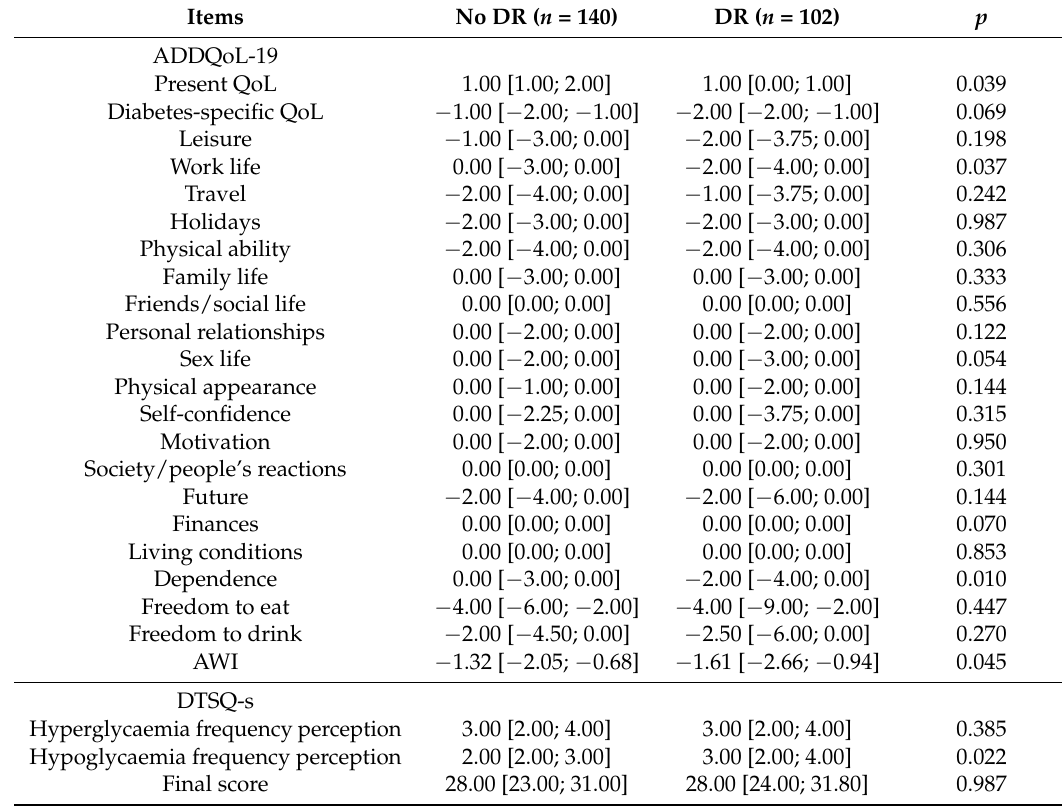
Table 2. Bivariate analysis for the Audit of Diabetes Dependent Quality of Life (ADDQoL-19) and